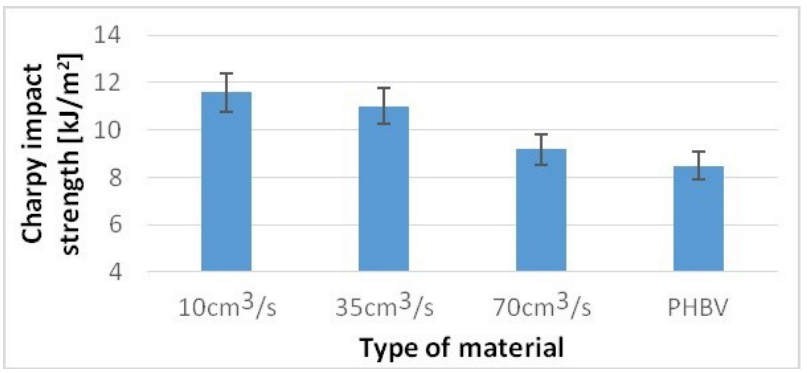
Figure 8. The Charpy impact strength of tested samples produced at a variable injection rate com- pared to a pure PHBV sample produced at 35 cm 3 /s. compared to a pure PHBV sample produced at 35 cm 3